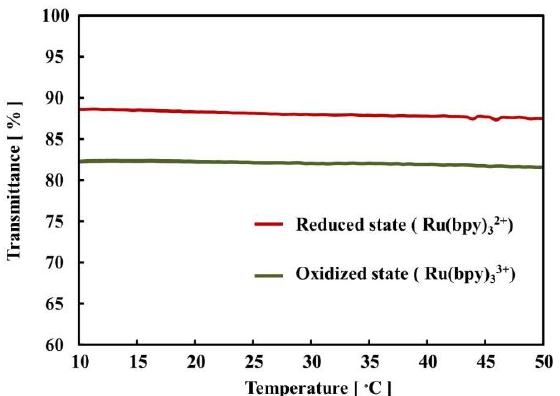
Figure 4. Temperature dependence of transmittance of poly(VP- co -Ru(bpy) under the reduced Ru(II) (in Ce(III) solution) and oxidized Ru(III) (in Ce(IV) solution)